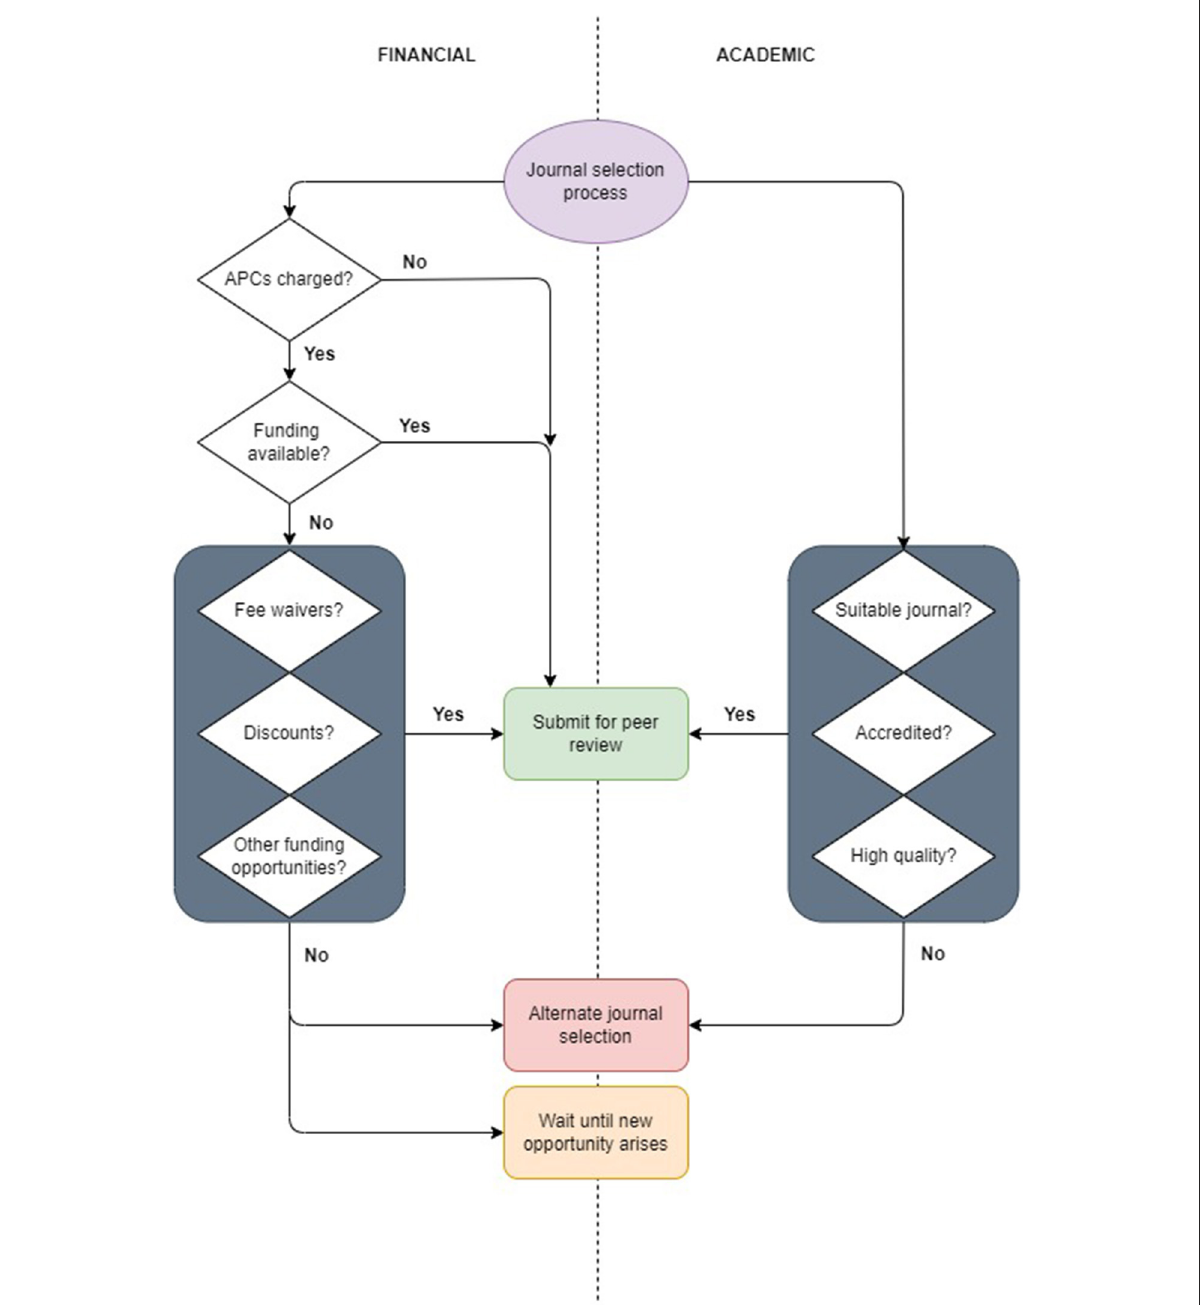
FIGURE1 Journal selection algorithm. The arrows indicate the journal selection process when APCs are charged vs. when no APCs are charged from a financial and academic perspective. APCs, article processing charges. Image created by JVR/JM using draw IO network diagrams (https://app.